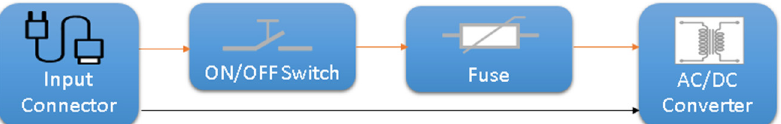
Figure 2. Block diagram of the AC input circuit.